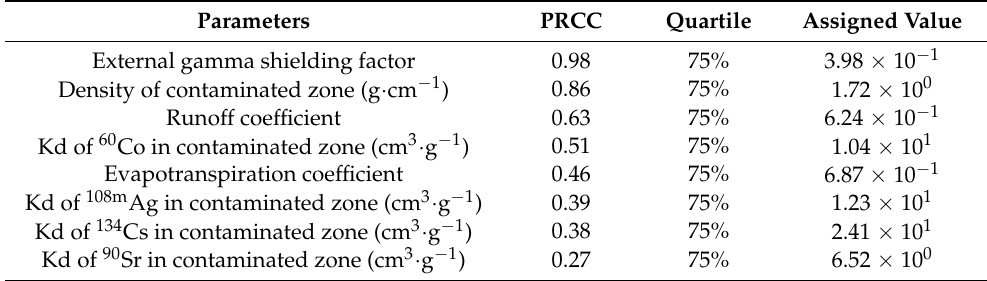
Table 6. Input parameters derived from the sensitivity analysis.